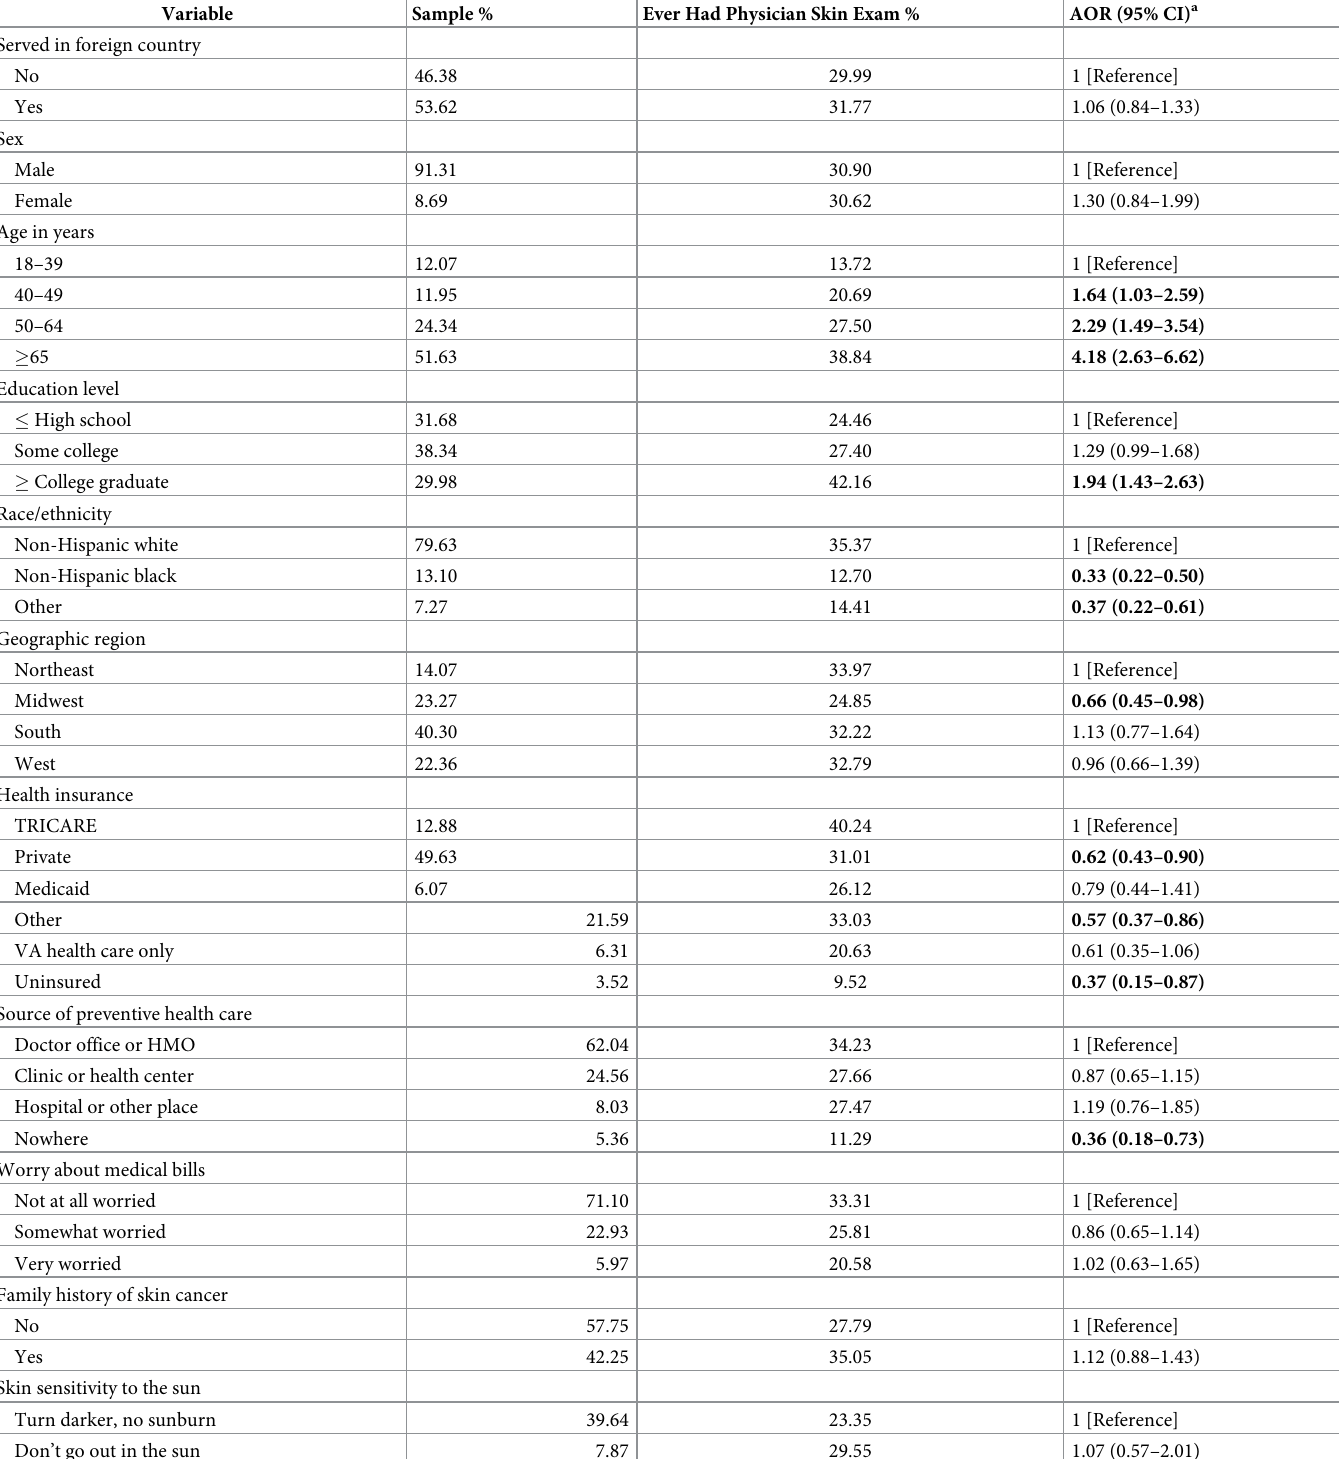
Table 1. Sample characteristics, physician skin exam screening rates, and multivariable correlates of receipt of a physician skin exam among 2,826 U.S. military vet- erans, 2015 National Health Interview